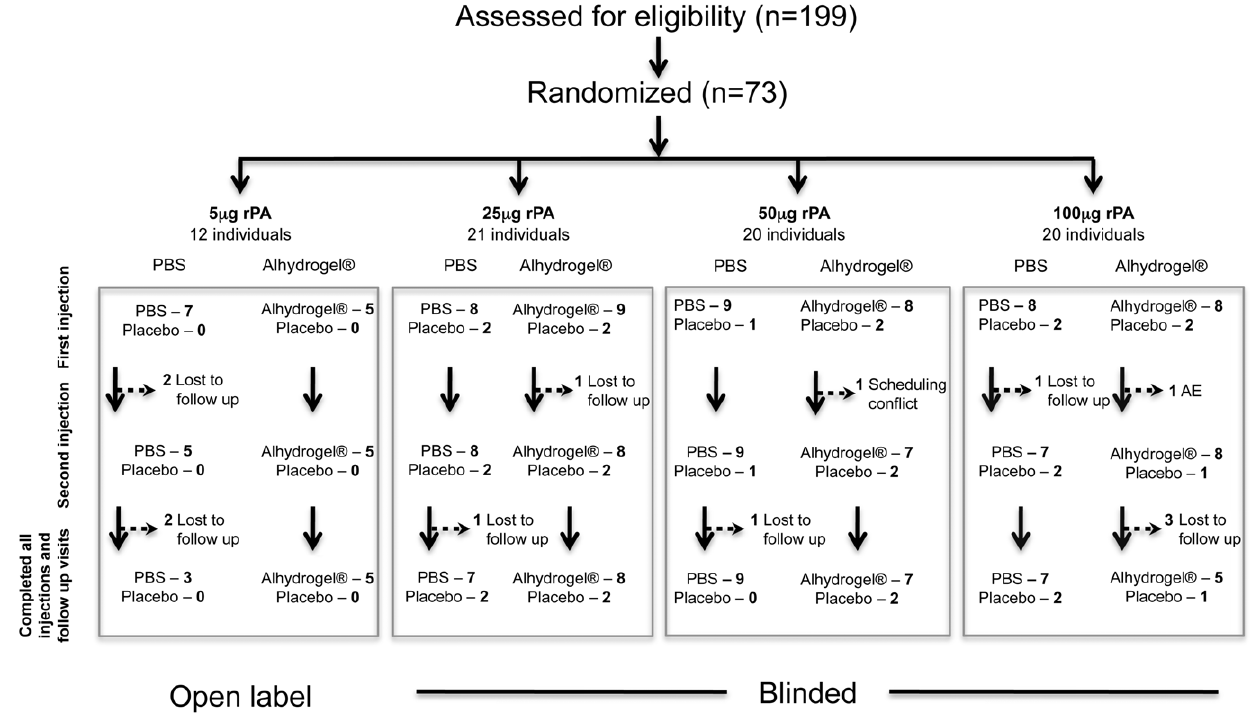
Figure 1. CONSORT flowchart.